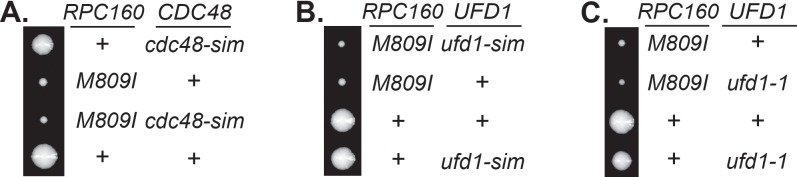
Genetic relationship between rpc160, cdc48, and ufd1.(A–C) Tetrad analysis between rpc160-M809I and cdc48-sim, ufd1-sim, and ufd1-1, respectively, showing none of these mutations rescued rpc160-M809I.